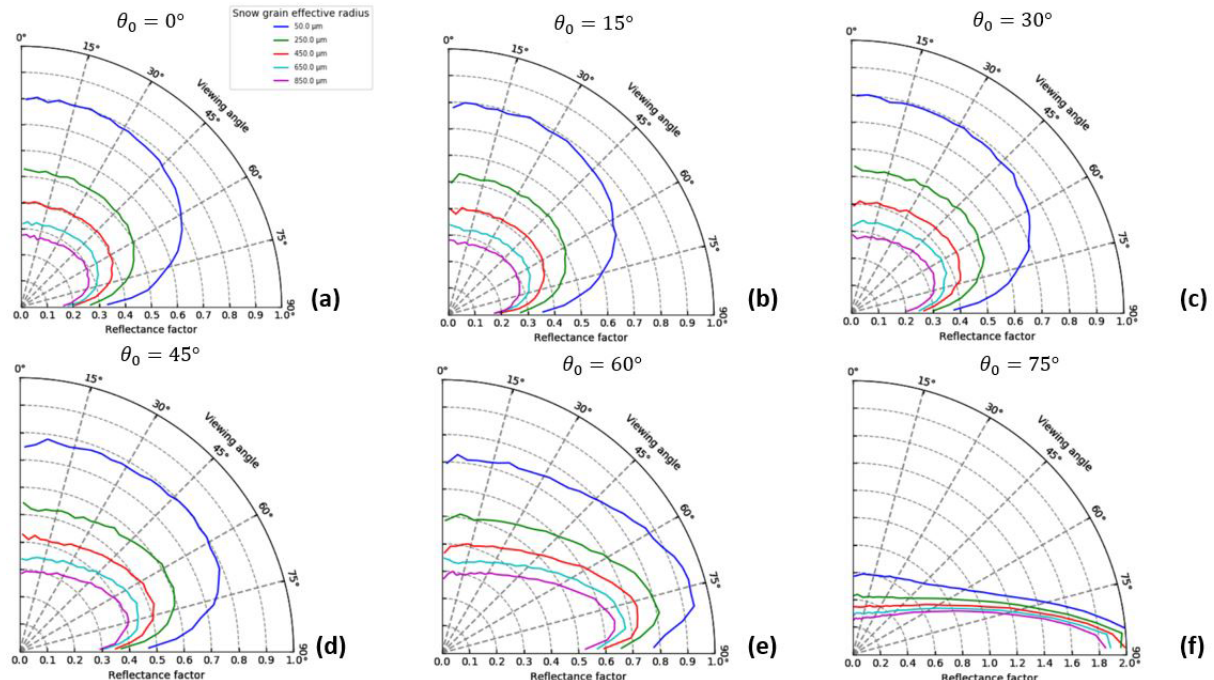
Figure 9. Polar plots of azimuthally averaged bidirectional reflectance factors (BRF) of modeled snowpacks with various snow grain radii, six illumination angles, and λ = 1 . 035µm. The radial dimension for (f) has been extended to capture the full extent of the localized BRF.